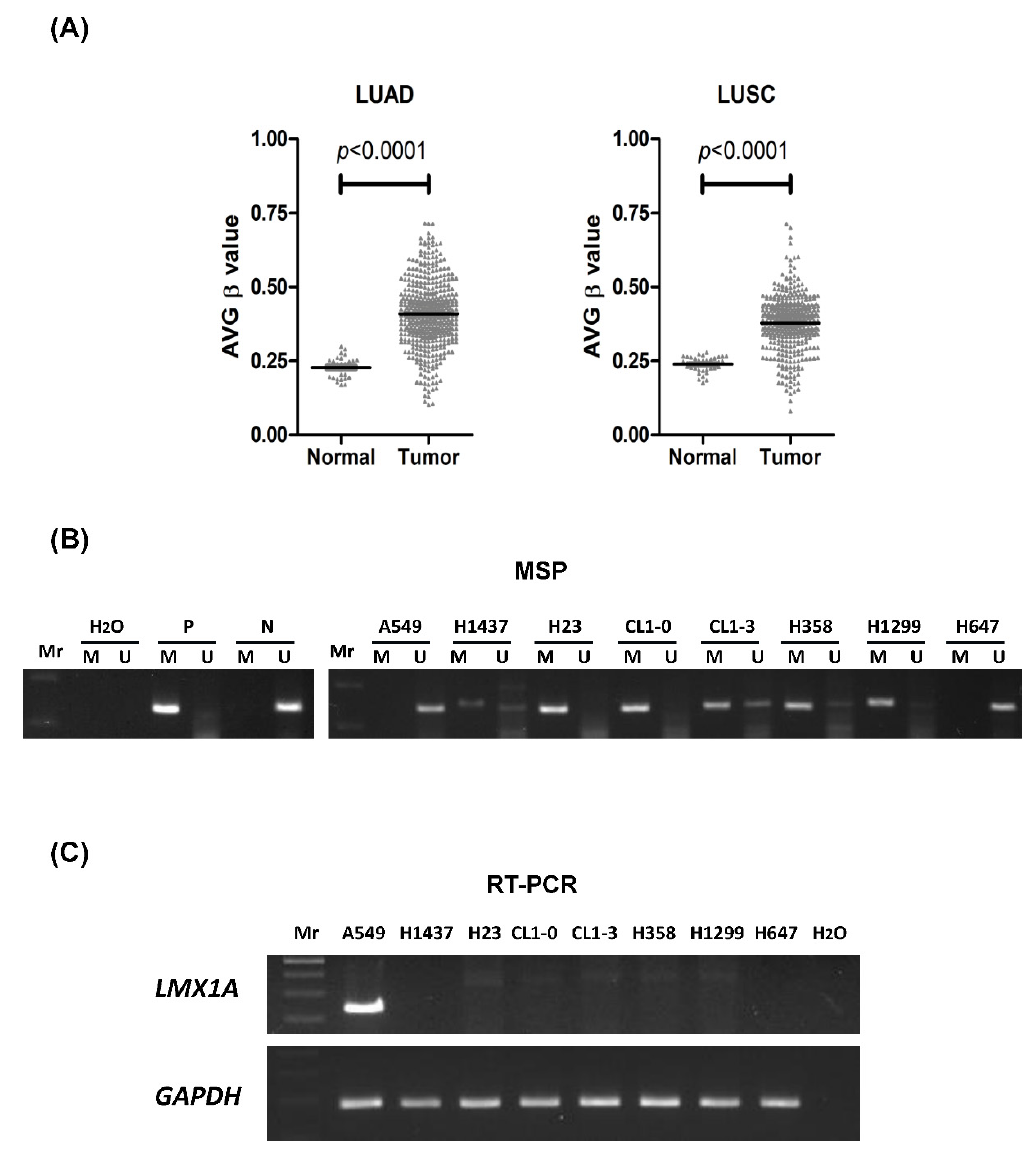
Figure 1. Promoter methylation levels of LMX1A in non-small cell lung cancer (NSCLC). ( A ) DNA methylation array data for LMX1A in 41 tissue samples from healthy individuals, 458 tissue samples from lung adenocarcinoma (LUAD) patients, and 364 tissue samples from lung squamous cell carcinoma (LUSC) patients from the Smart App (http: // www.bioinfo-zs.com / smartapp) are shown. The results are shown as average (AVG) β values for the probes. Black lines indicate the mean AVG β value. The p -values for LMX1A methylation levels among the groups (normal versus tumor) were determined by the Mann–Whitney U test. ( B ) The promoter methylation statuses of LMX1A in eight NSCLC cell lines were analyzed by methylation-specific PCR (MSP) with methylated and unmethylated-specific primers. P: Positive control; N: Negative control. ( C ) Gene expression levels of LMX1A and the internal reference GAPDH in eight NSCLC cell lines were analyzed by reverse transcription polymerase chain reaction (RT-PCR). Mr: Molecular marker, or DNA ladder.